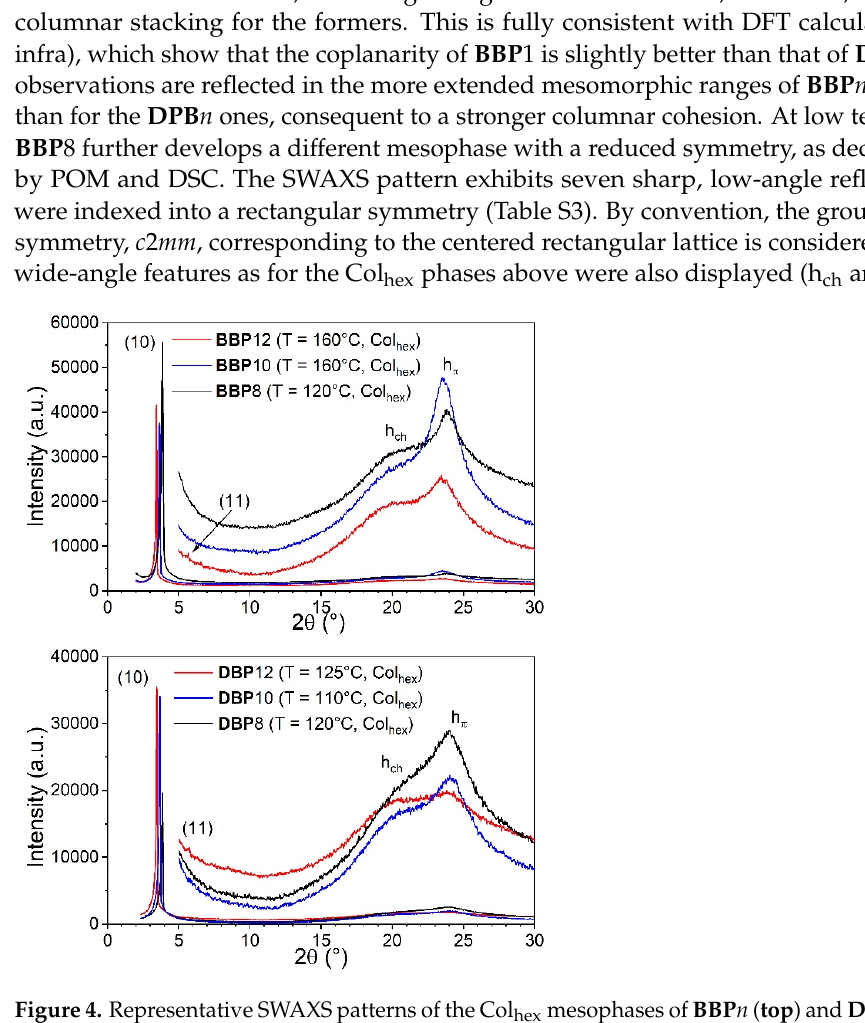
Figure 4. Representative SWAXS patterns of the Col hex mesophases of BBP n ( top ) and DBP n ( bottom ) at different temperatures. Table 1. Compounds and mesophase parameters and geometrical data.